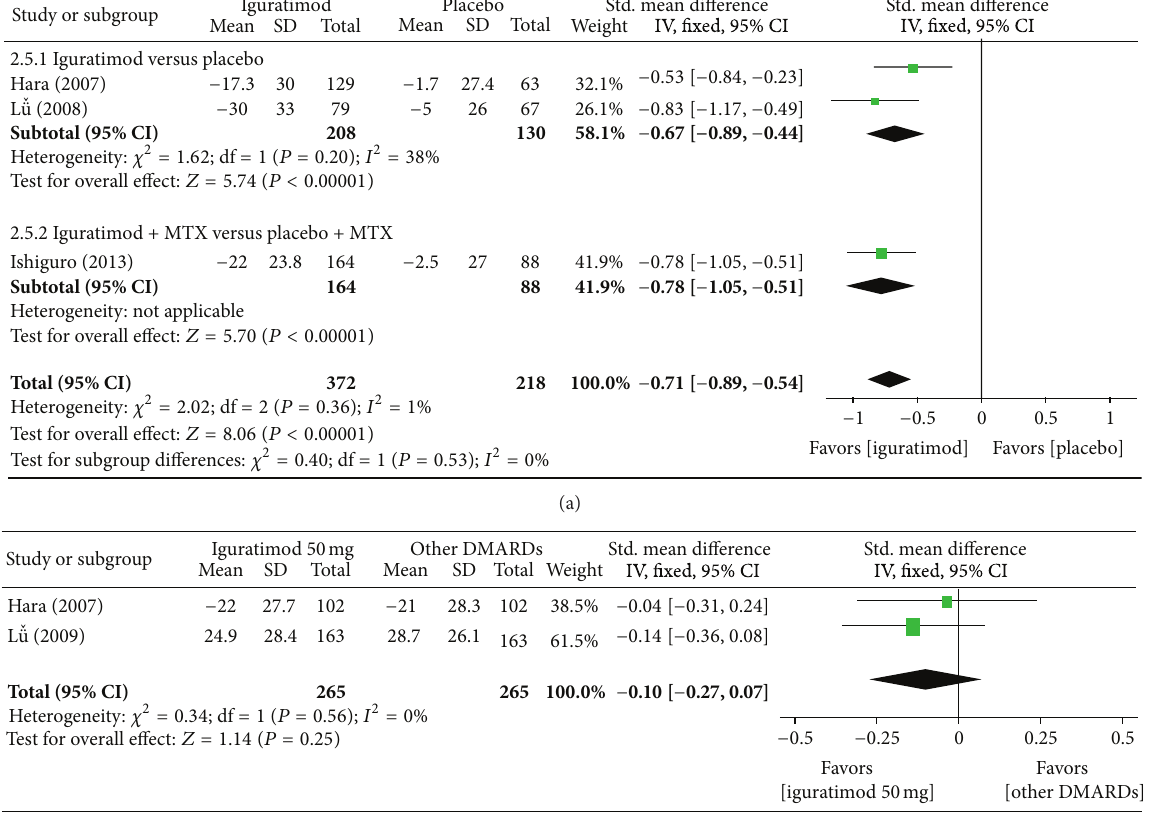
Figure 7: (a) Comparison of assessment of rest pain between iguratimod and placebo groups. (b) Comparison of assessment of rest pain between iguratimod and other DMARDs (MTX and SASP)